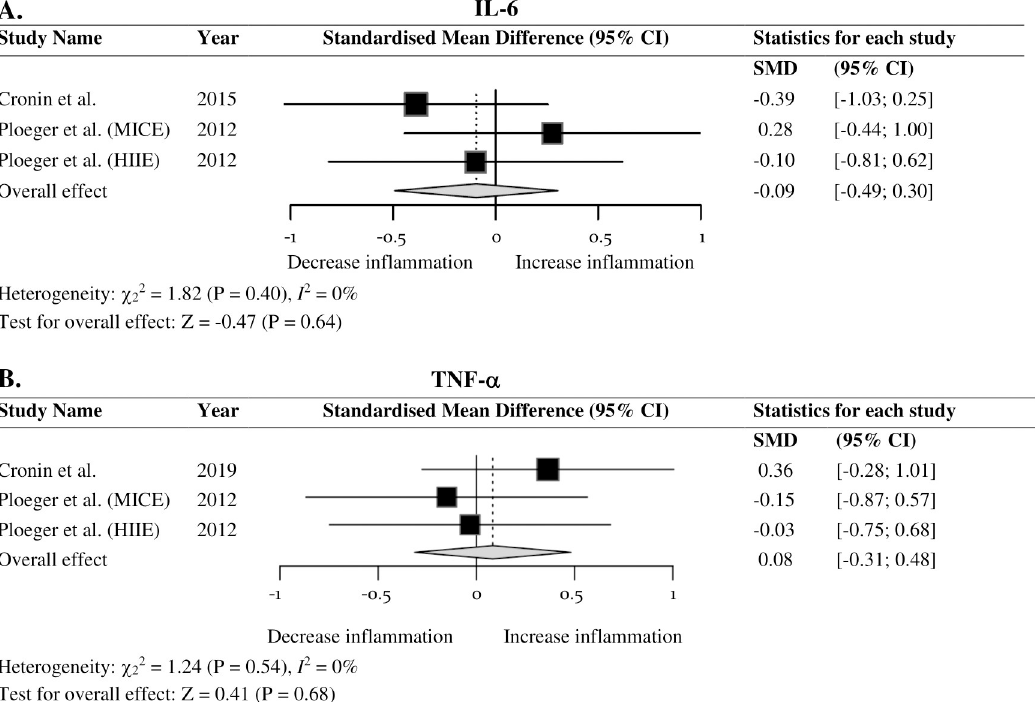
Fig 2. Forest plot of the combined effect of exercise on inflammatory markers in IBD. (A) IL–6. (B) TNF– α . Size of squares is proportional to weight of the study. Hedges’ g expressed as standardised mean difference ( SMD ) and 95% confidence interval ( CI ).